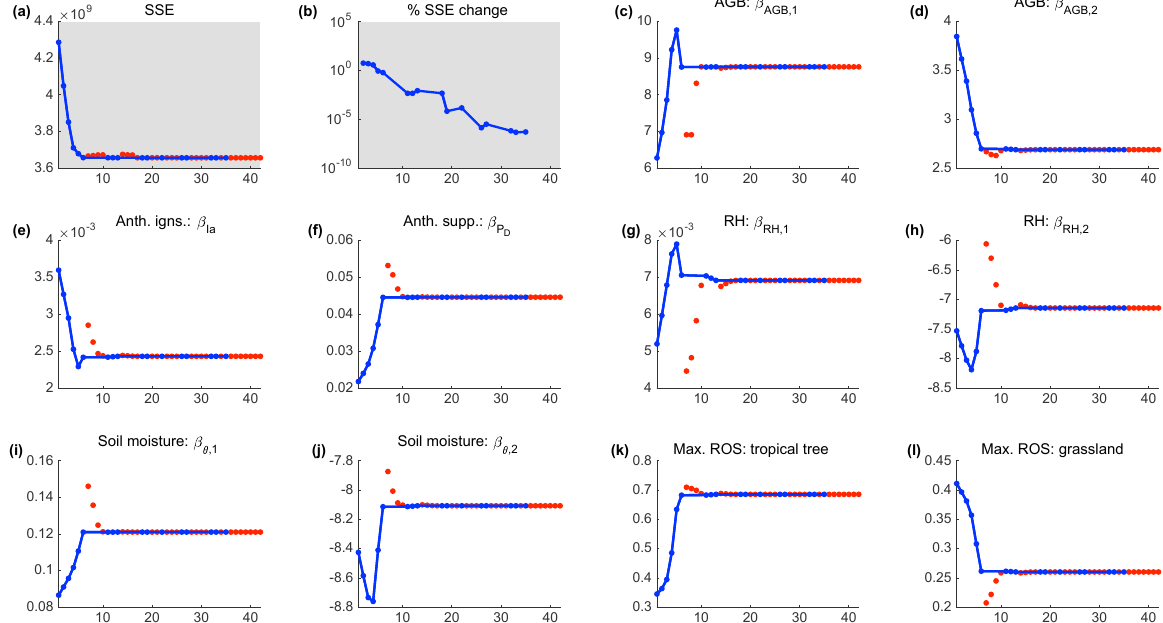
Figure 2. Trace plots showing the progression of sum of squared errors (SSE) (a) , the percent change in SSE between each accepted parameter set (b) , and each of the ten parameters (c–l) over the length of the optimization. x axes show iteration number, y axes show sum of squared errors or parameter guess value, and color of points indicate whether the associated parameter set guess was accepted (blue) or rejected